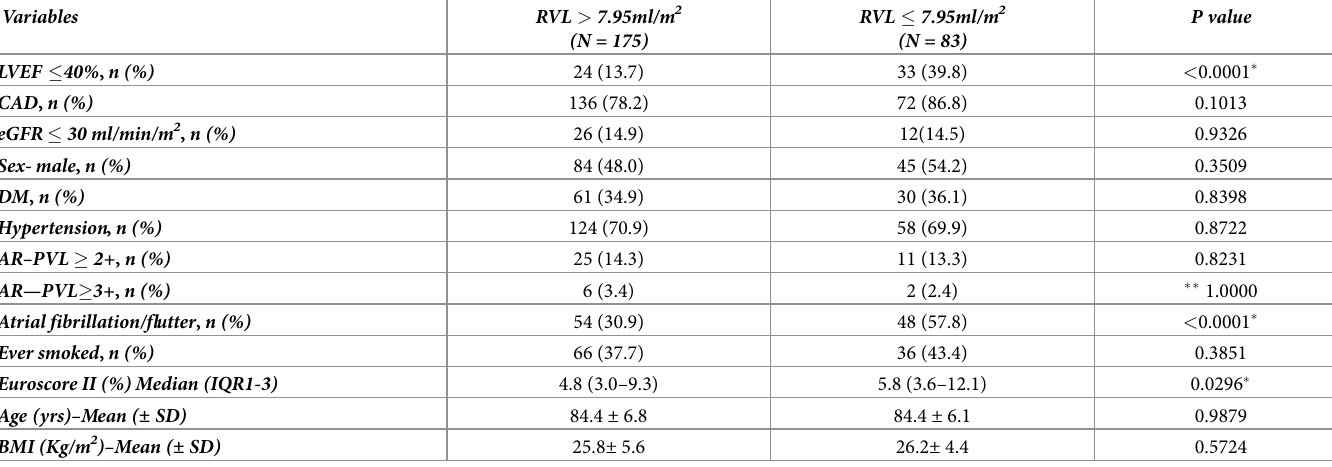
Table 4. Comparison of clinical and hemodynamic variables in patients with RVL > 7.95ml/m 2 and RVL (cid:20) 7 . 95ml/m 2